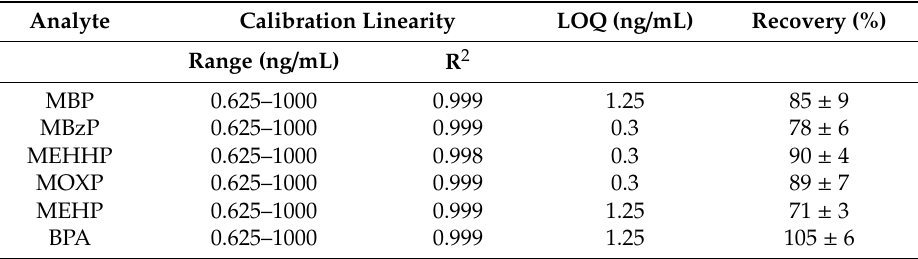
Table 1. Limit of quantification (LOQ) of the investigated endocrine disruptors.